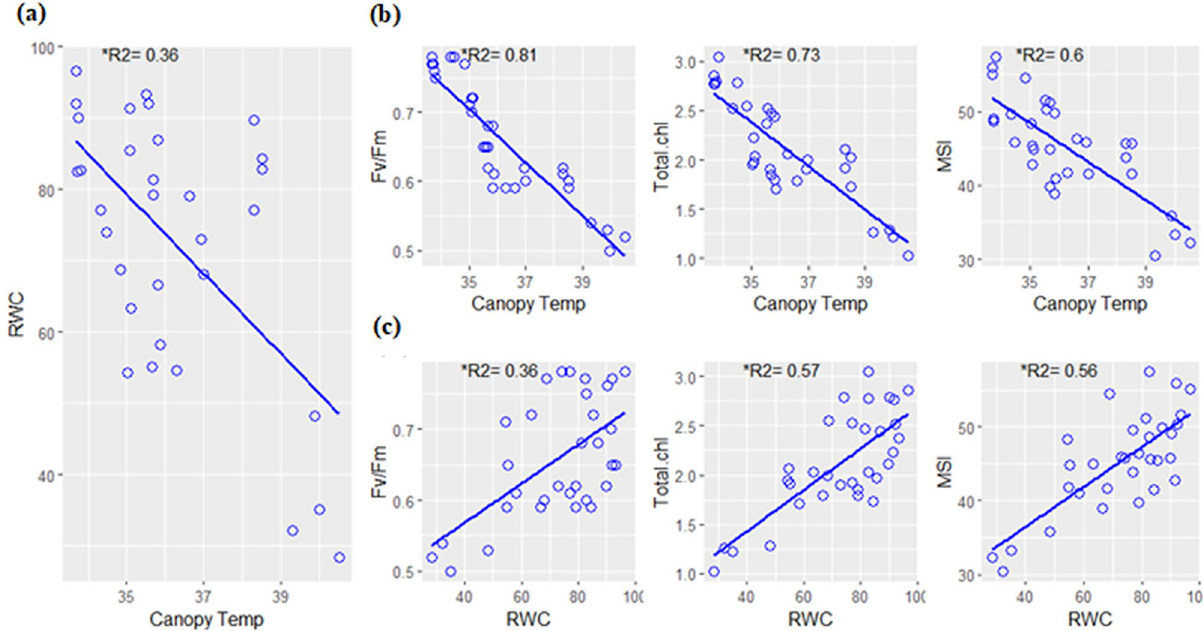
Figure 5. Coefficient of determination (R2) computed to reveal association among variables (A) RWC (%) and Canopy Temperature (°C) (B) F v /F m , Total Chlorophyll (mg/g fresh weight) and MSI(%) versus Canopy Temperature (°C) and (C) F v /F m , Total Chlorophyll (mg/g fresh weight) and MSI (%) versus RWC